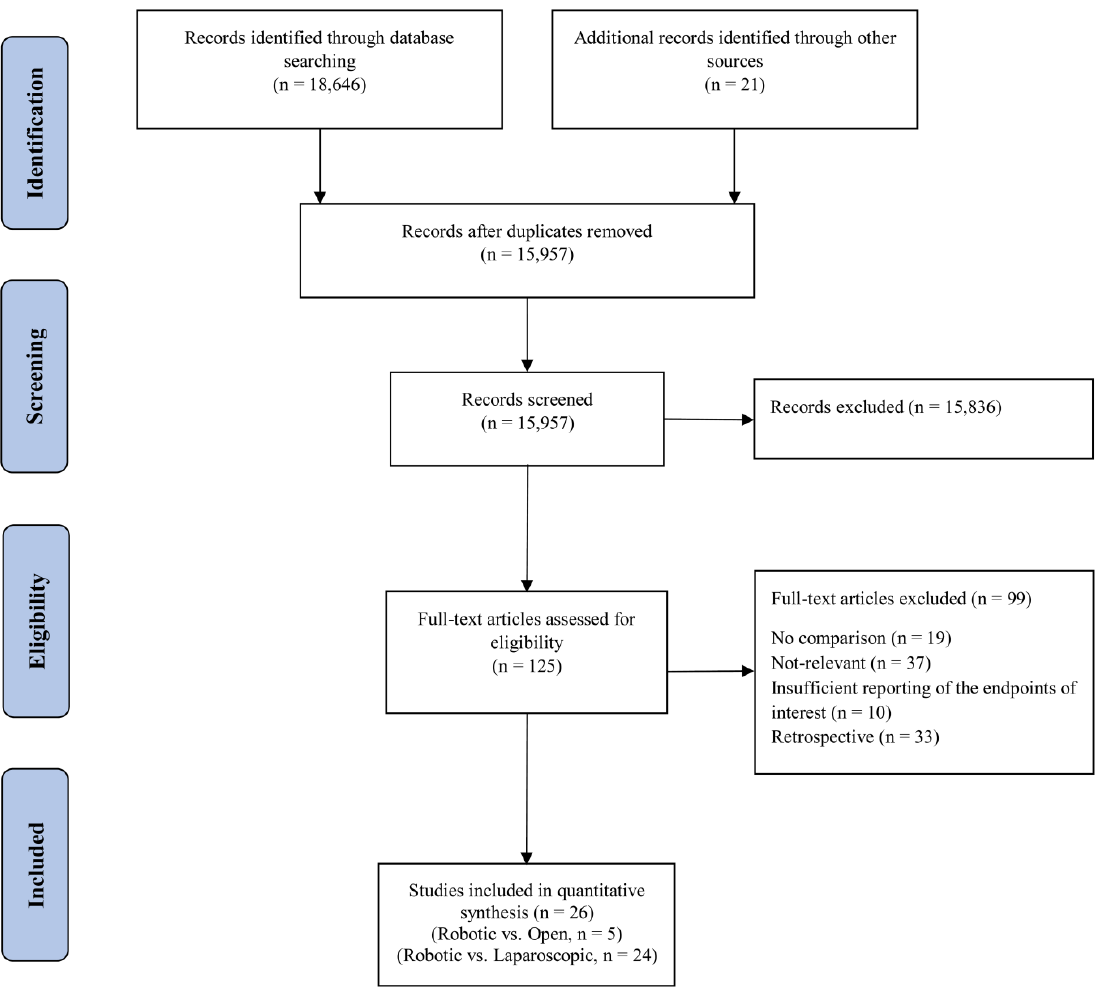
Figure 1. PRISMA flow chart showing the selection of articles for review.